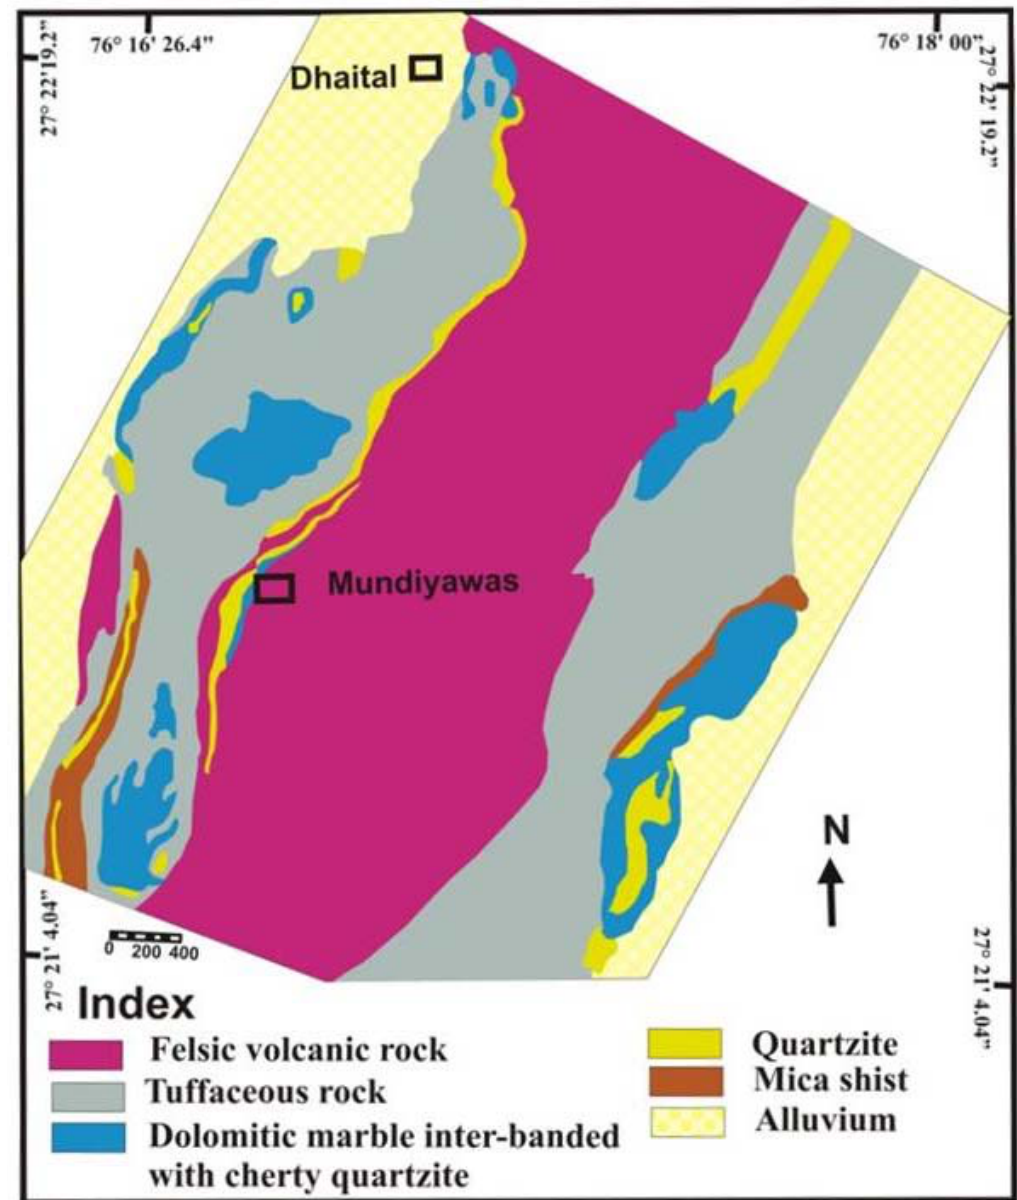
Figure 3. Simplified geological map of the study area (Mundiyawas-Khera area) (modified after [14,51]). Mundiyawas and Dhaital are two localities around the deposit and shown in the map.